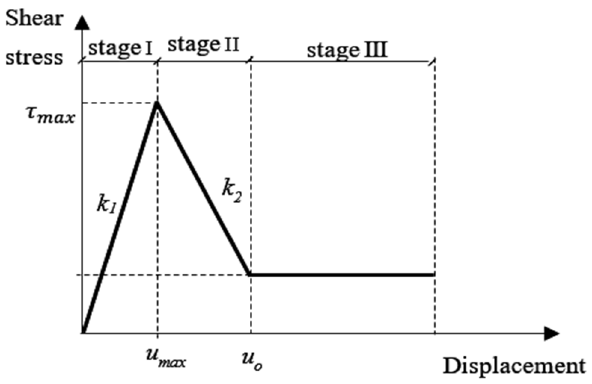
Figure 13. Shear stress-displacement relationship at the matrix-textile interface [41].